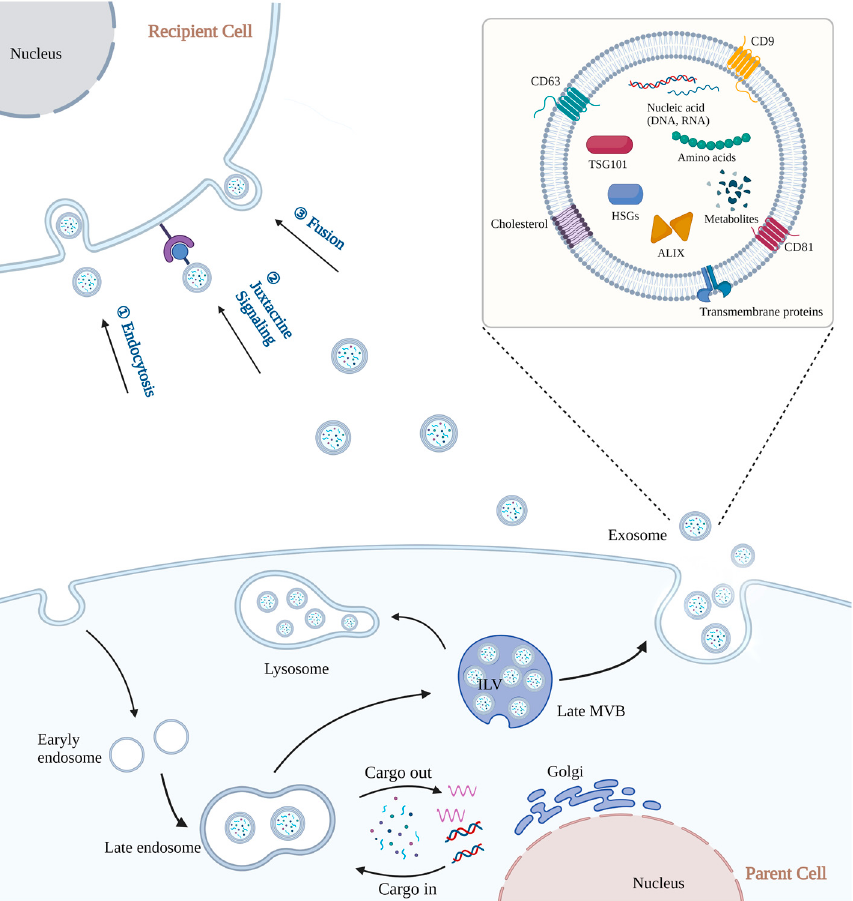
Figure 1. The biogenesis and cellular uptake modes of natural exosomes. During inward budding of the endosomal membrane, cargos are sorted into the forming vesicles through specific protein complex. By fusion of the MLVs with plasma membrane, exosomes are secreted into extracellular environment. Three ways of exosome cellular uptake: (1) endocytosis; (2) juxtacrine signaling; (3)